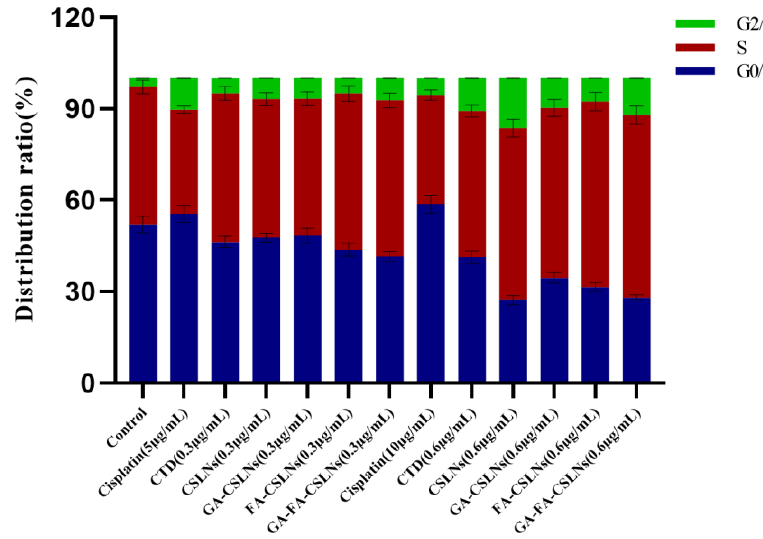
Figure 10. Cell-cycle distribution of HepG2 cells (mean ± SD, n = 3).